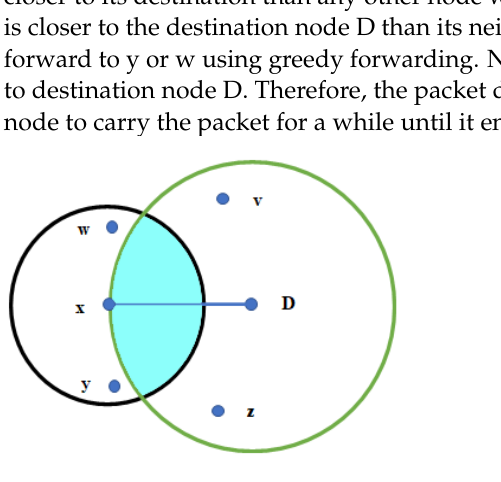
Figure 1. Local-maximum problem when a packet reaches node x that is closer to its destination node D than any other node (w,y,v,z) within the range.